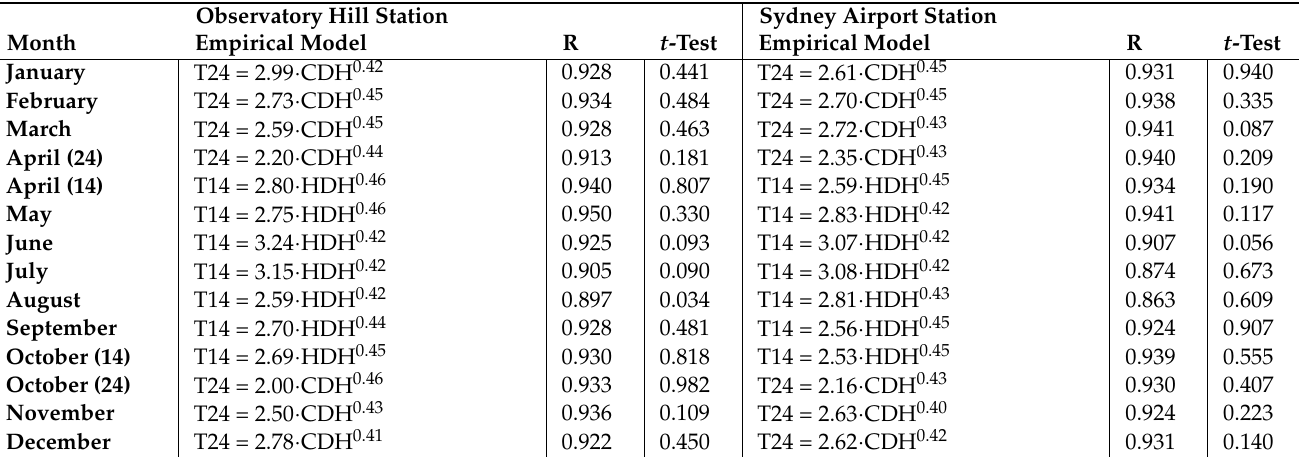
Table 4. Daily number of hours with temperature over 24 ◦ C (T24) or below 14 ◦ C (T14) empirical models using cooling and heating degree hours (CDH and HDH), with their equivalent regression coefficients and paired t -test of goodness of fit with the observed daily values of